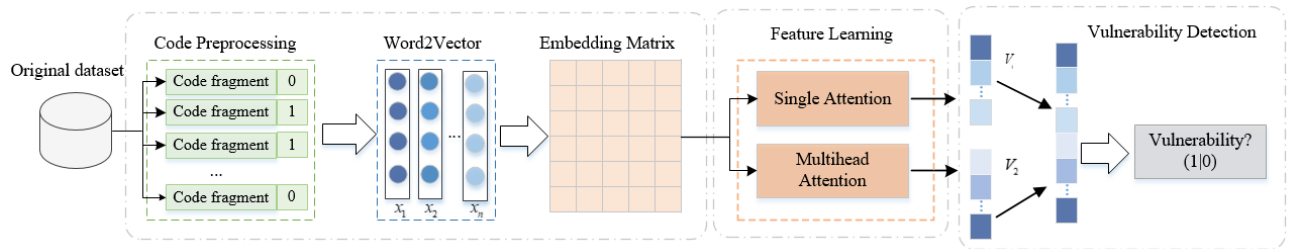
Figure 6. The overall process of our